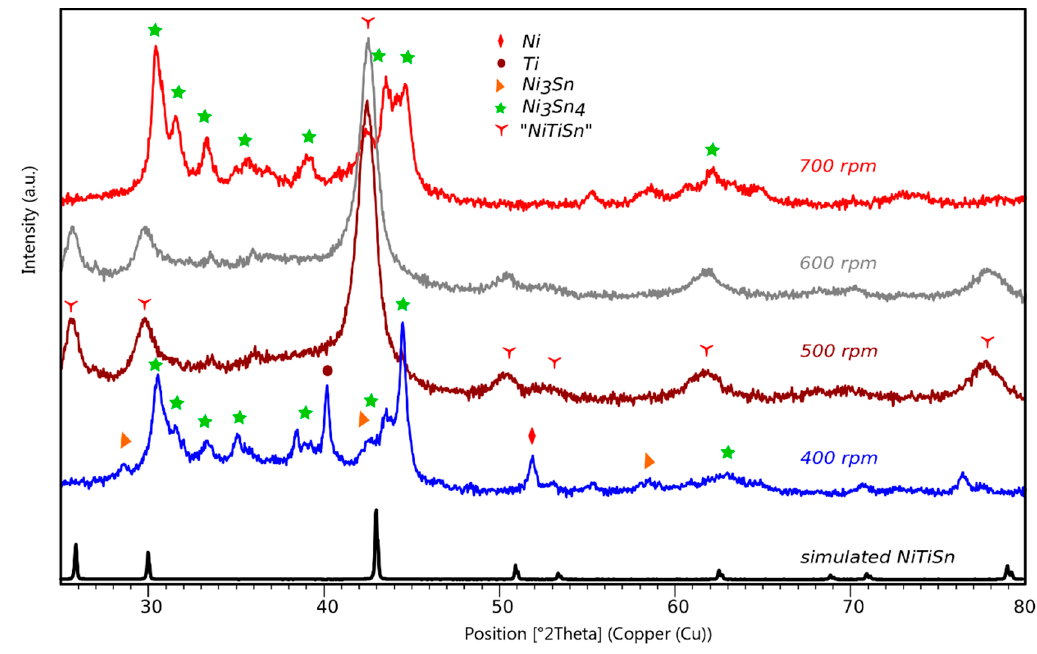
Figure 3. XRD patterns for samples prepared by MA during 43 h. Provided energy varies with rotation speed taken from 400 to 700 rpm.